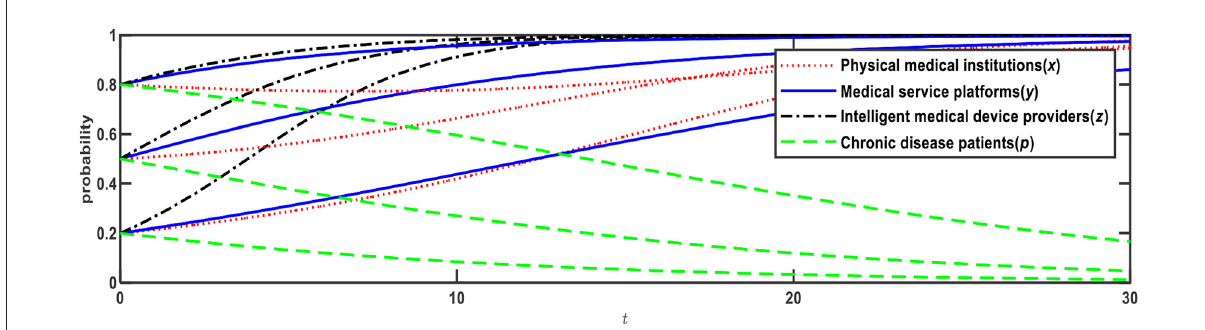
FIGURE8 Evolution of E15 (1,1,1,0).